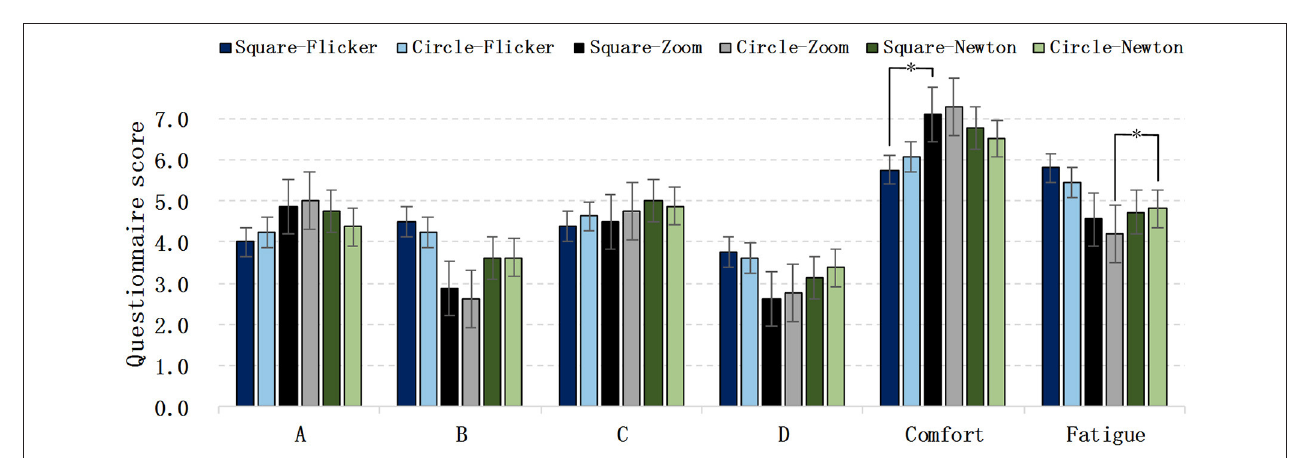
FIGURE 7 | Visual comfort evaluation of different